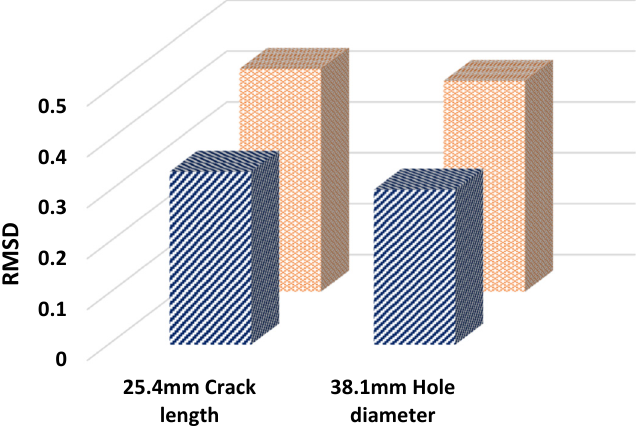
Figure 27. FFT Admittance spectrums for an undamaged and damaged concrete beam with: ( a , c ) active wave propagation; ( b , d ) when an EMI admittance sensor is activated simultaneously with wave propagation.